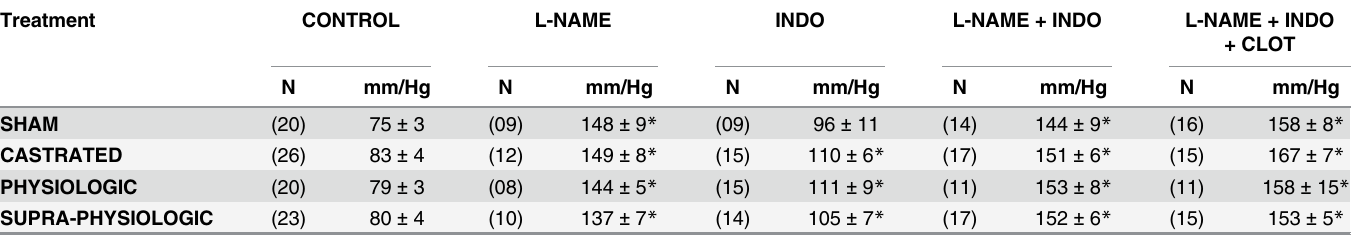
Table 2. Coronary perfusion pressure (CPP, mmHg) in normotensive rats after inhibition with 100 μ M L-NAME, 28 μ M indomethacin (INDO), L-NAME + INDO, or L-NAME + INDO + 0.75 μ M clotrimazole. Treatment